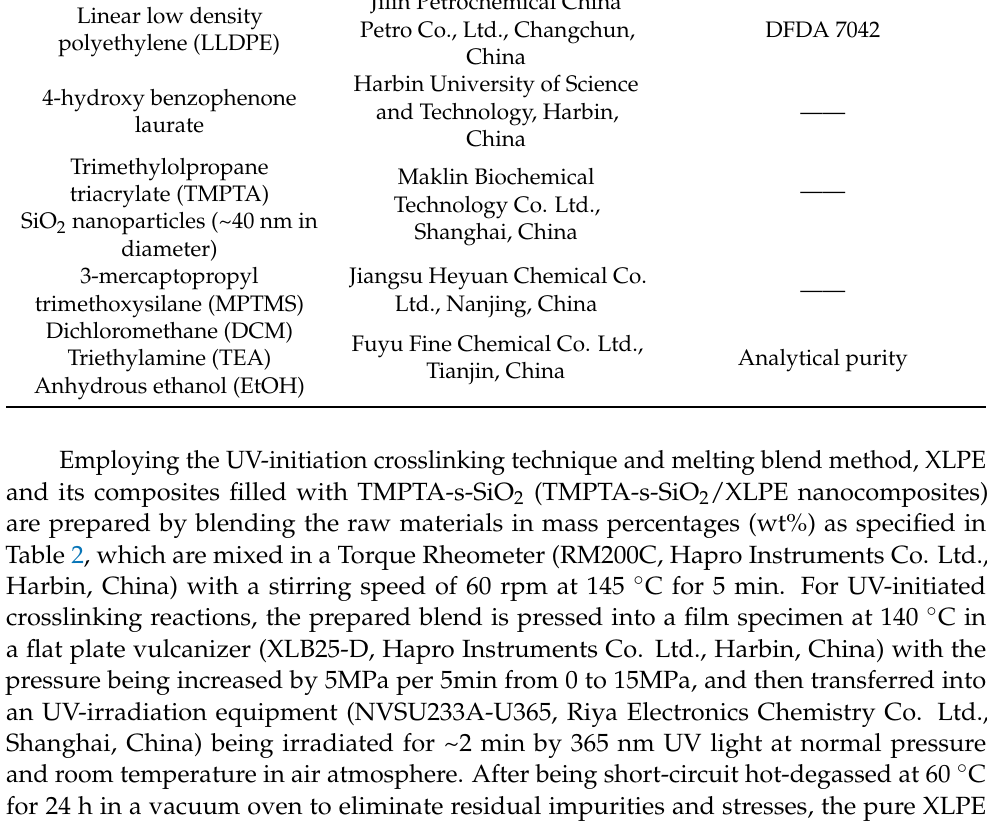
Table 1. Raw materials for preparing TMPTA surface-modified SiO 2 nanoparticles. Materials